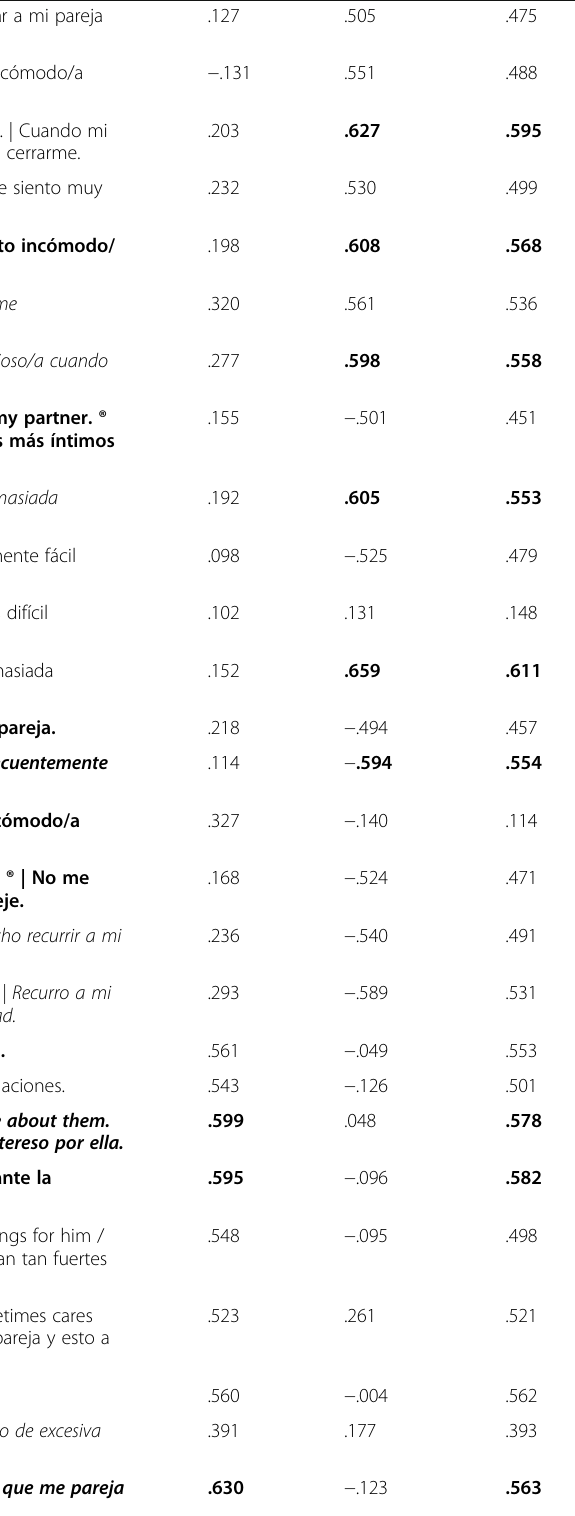
Table 4 Saturation coefficients and item-total correlations for the 36 items in sample 1 Item Anxiety Avoidance Item-total